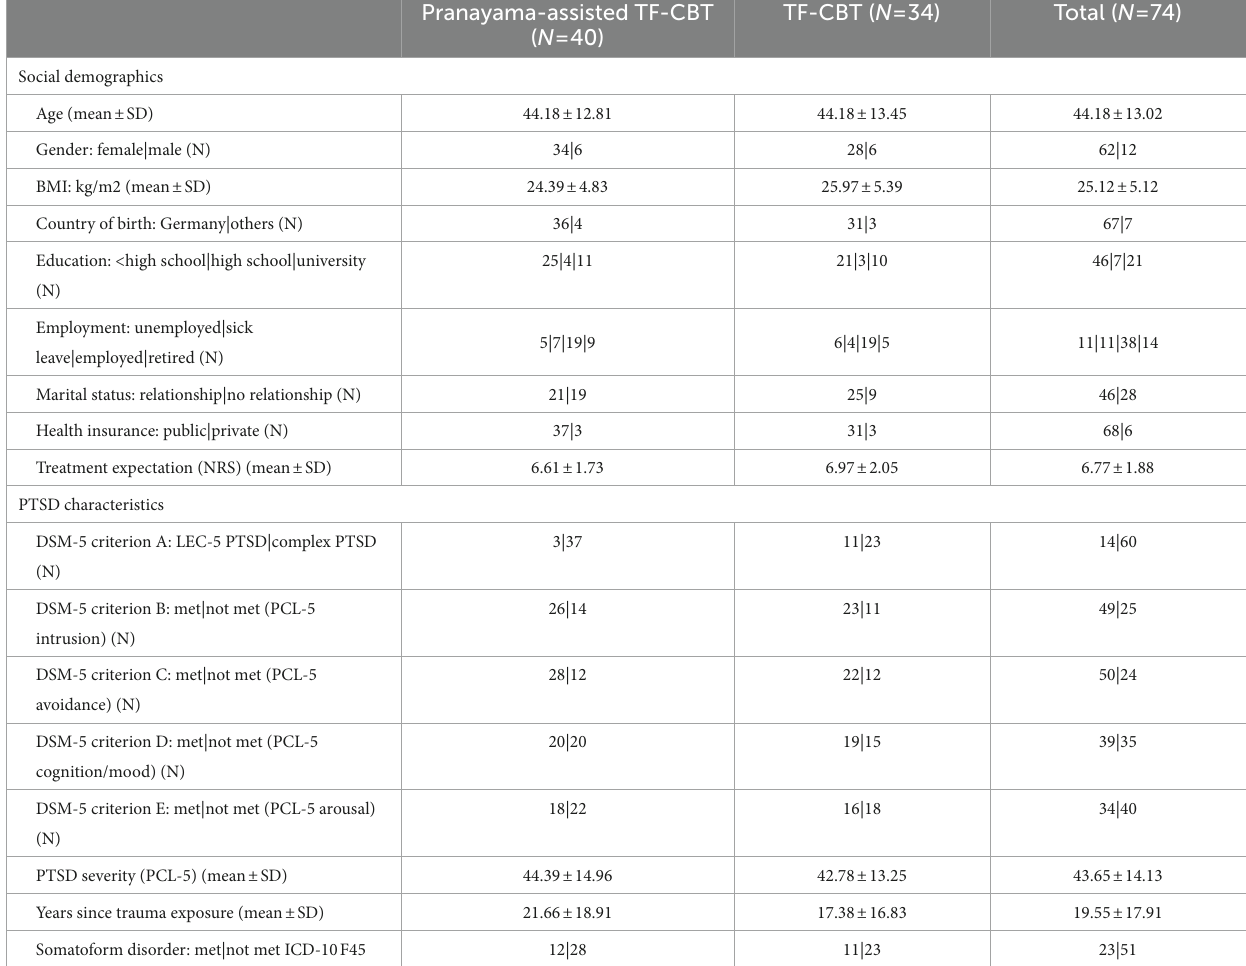
TABLE 2 Sample characteristics at